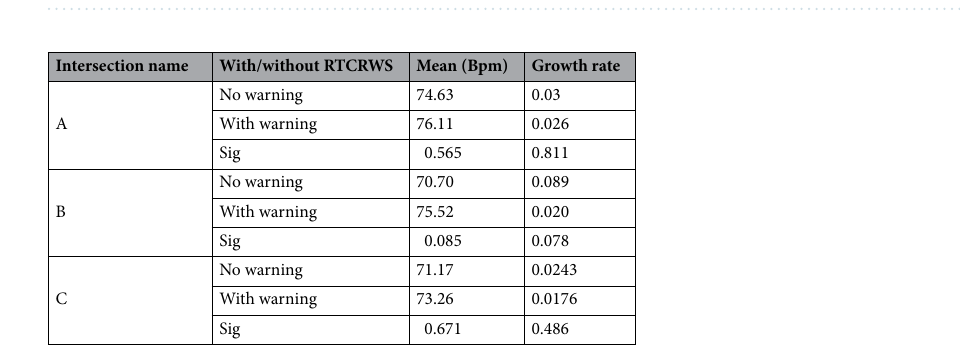
Figure 11. PET values of 3 intersection.